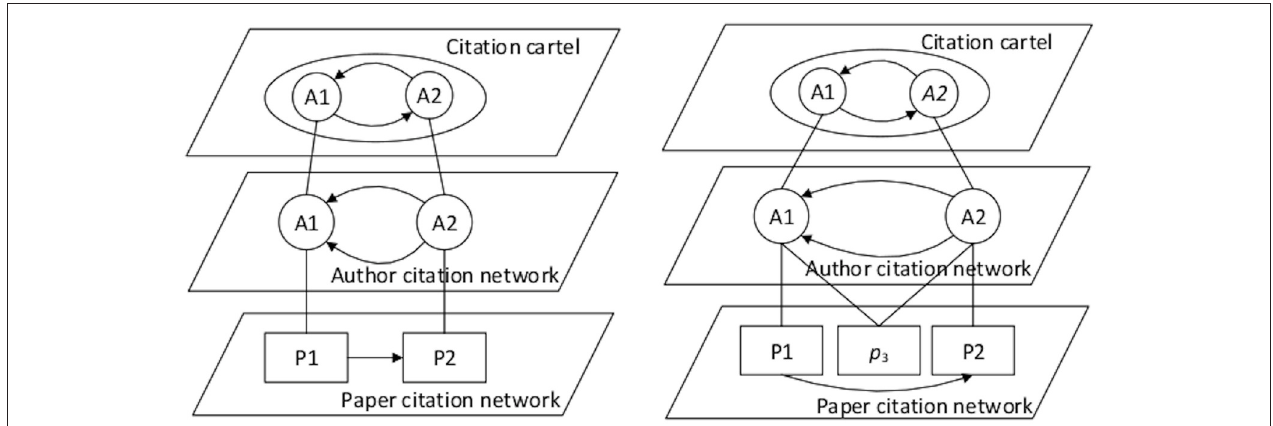
FIGURE 2 | Schematic illustration of citation networks using relations in the so-called Resource Description Framework (RDF). Scenario 1, on the left, presents a situation, where authors A1 and A2 do not have any mutual papers, i.e., negation of conjunctive relation ¬ ( IsAuthorOf (A1,P3) ∧ IsAuthorOf (A2,P3)) in Equation (2) is valid. In this case, they are not familiar with each other. Therefore, this kind of a citation cartel is hard to detect. Scenario 2, depicted at the right, presents a situation, where authors A1 and A2 have at least one mutual paper, i.e., conjunctive relation IsAuthorOf (A1,P3) ∧ IsAuthorOf (A2,P3) in Equation (3) holds. In this case, authors are familiar with each other and therefore deliberately help each other in achieving higher citation